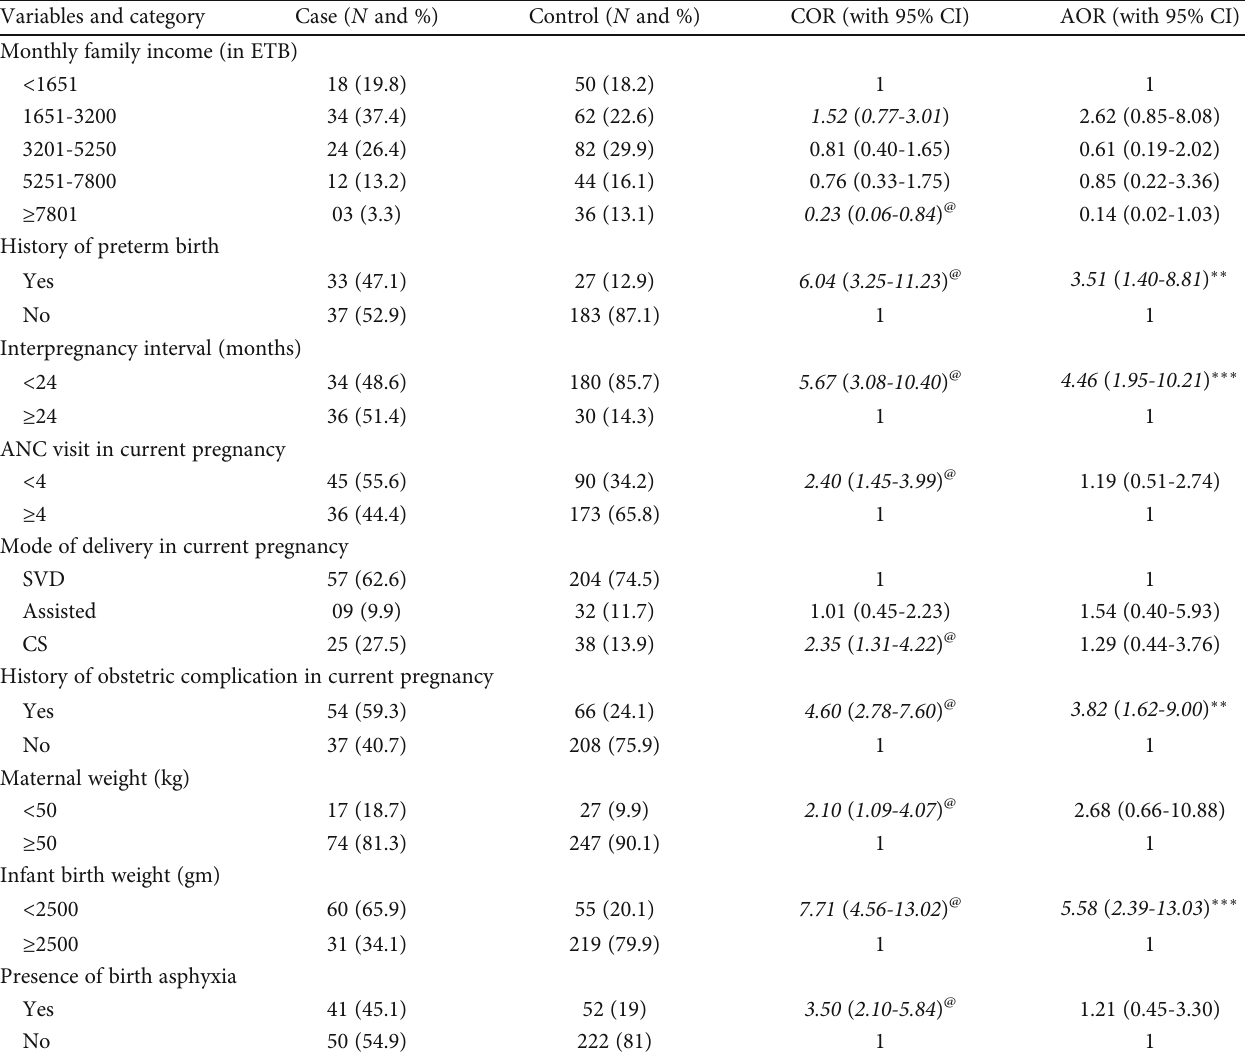
Table 4: Bivariate and multivariable logistic regression analysis for determinants of PTB among mothers who gave birth in Silte Zone Public Hospitals, Southern Ethiopia